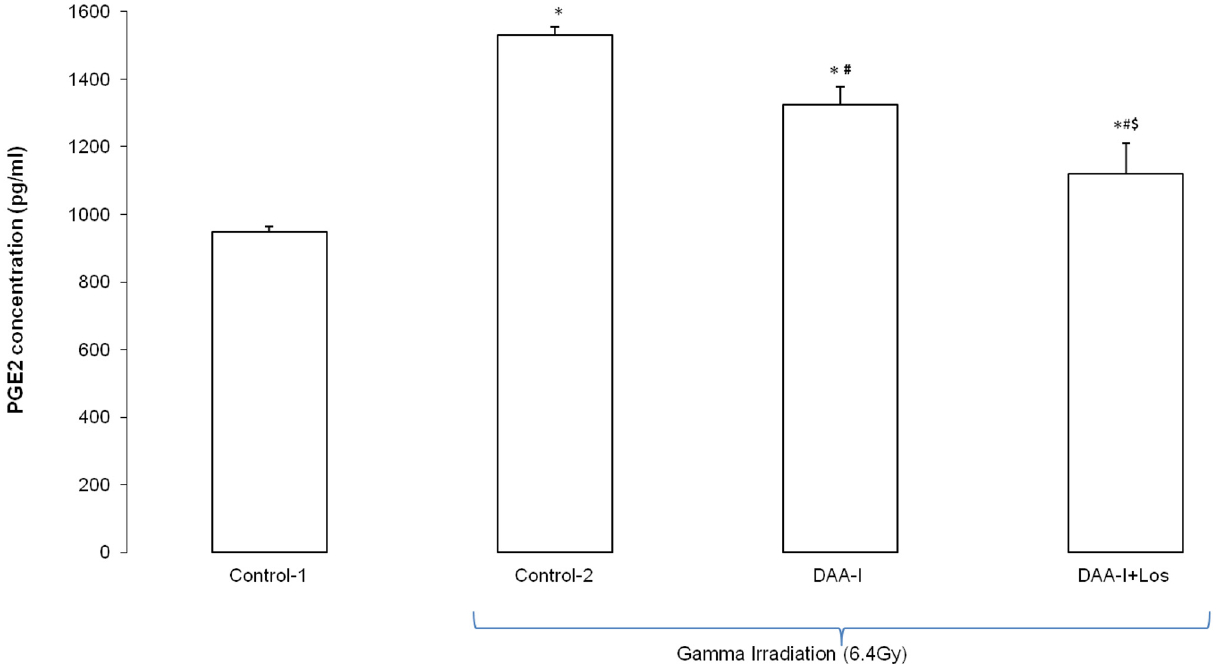
Fig 4. Effect of DAA-I and DAA-I plus losartan on the plasma level of PGE 2 in gamma irradiates mice. Control-1: animals were orally administered 0.1 ml vehicle (water) and were not irradiated. Control-2: animals were orally administered 0.1 ml vehicle and were irradiated. Each value was a mean ± S.E.M. obtained from 3 separate animals. Comparisons between groups was analyzed by One-Way ANOVA followed by Tukey ’ s post-hoc test. * p < 0.05 vs Control-1; # p < 0.05 vs Control 2; $ p < 0.05 vs DAA-I